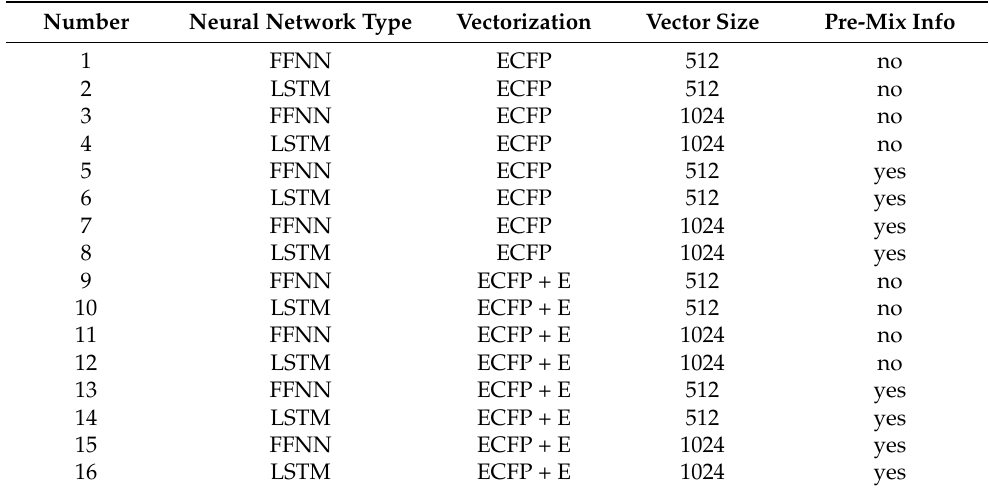
Table 3. Combinations the neural network types, vectorization types, vector sizes, and whether there is information on a mixture before the crystallization step. Neural Network